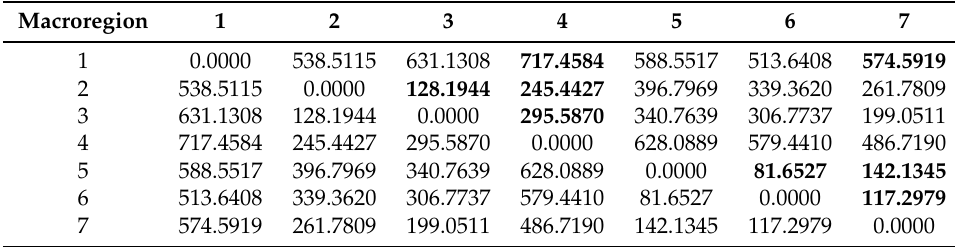
Table 4. Mahalanobis distances between